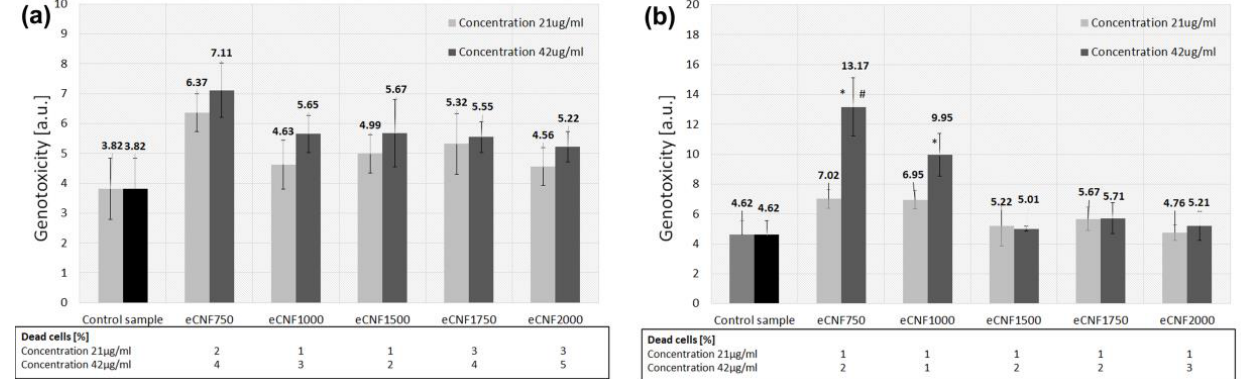
Figure 11. Results of genotoxicity of eCNFs in contact with the CHON-001 cell line using a comet assay after 1h ( a ) and 24 h ( b ) of culture. Two-way analysis of variance (ANOVA; control, concentration of eCNFs) with Student’s t-test post hoc test was used for statistical analysis. * p < 0.05 vs. PS for each time point; # p < 0.05 vs. eCNF concentration for each time